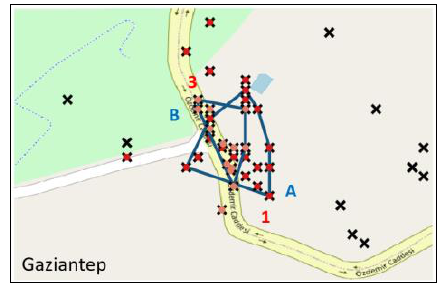
Figure 10. Mersin Region Repeatedly-detected Clusters